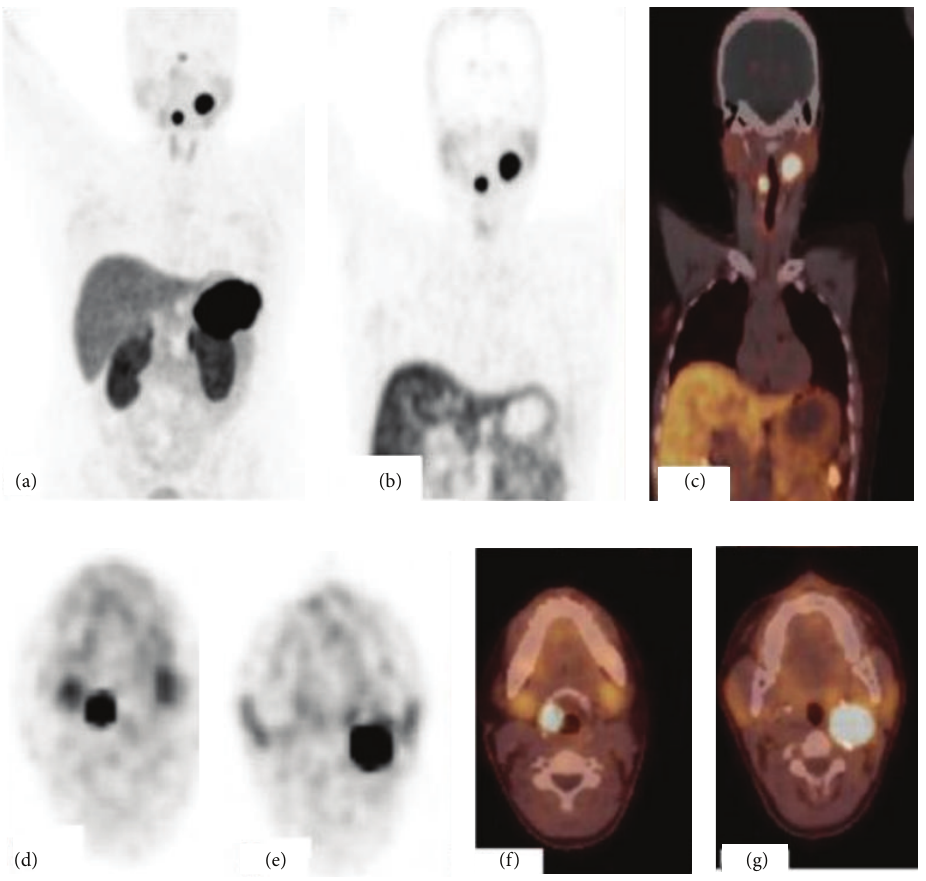
Figure 4: 68Ga-DOTANOC PET/CT; maximum intensity projection (MIP) image (a), coronal PET and PET/CT fusion images (b, c), and axial PET and PET/CT fusion images (d, e, f, and g) show an intense uptake by the right laryngeal paraganglioma and left carotid body